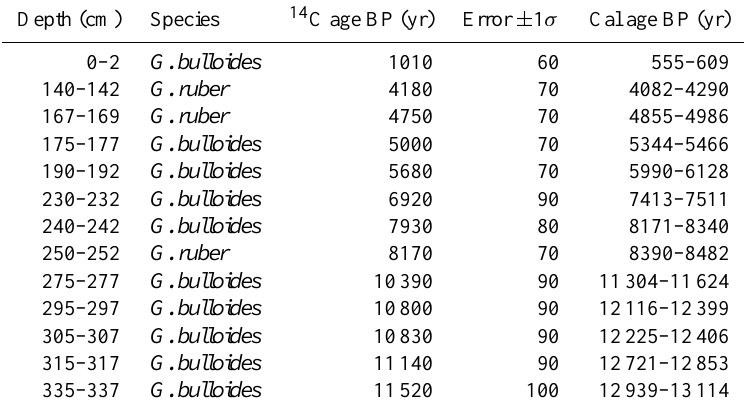
Table 1. Age model for core MD 90-917, AMS 14 C ages and corresponding calendar ages from INTCAL04 (Reimer et al., 2004) integrating 14 C reservoir age correction R(t) at 390 ± 85yr BP (Siani et al., 2000,